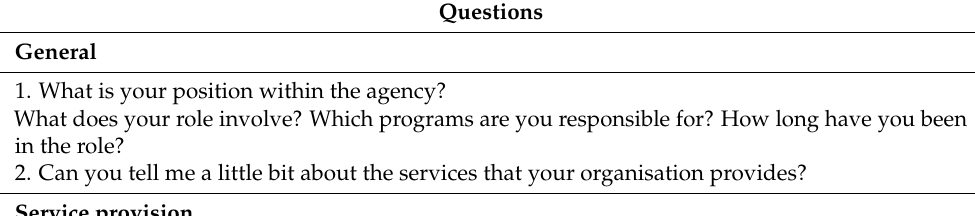
Table 1. Interview and focus group interview